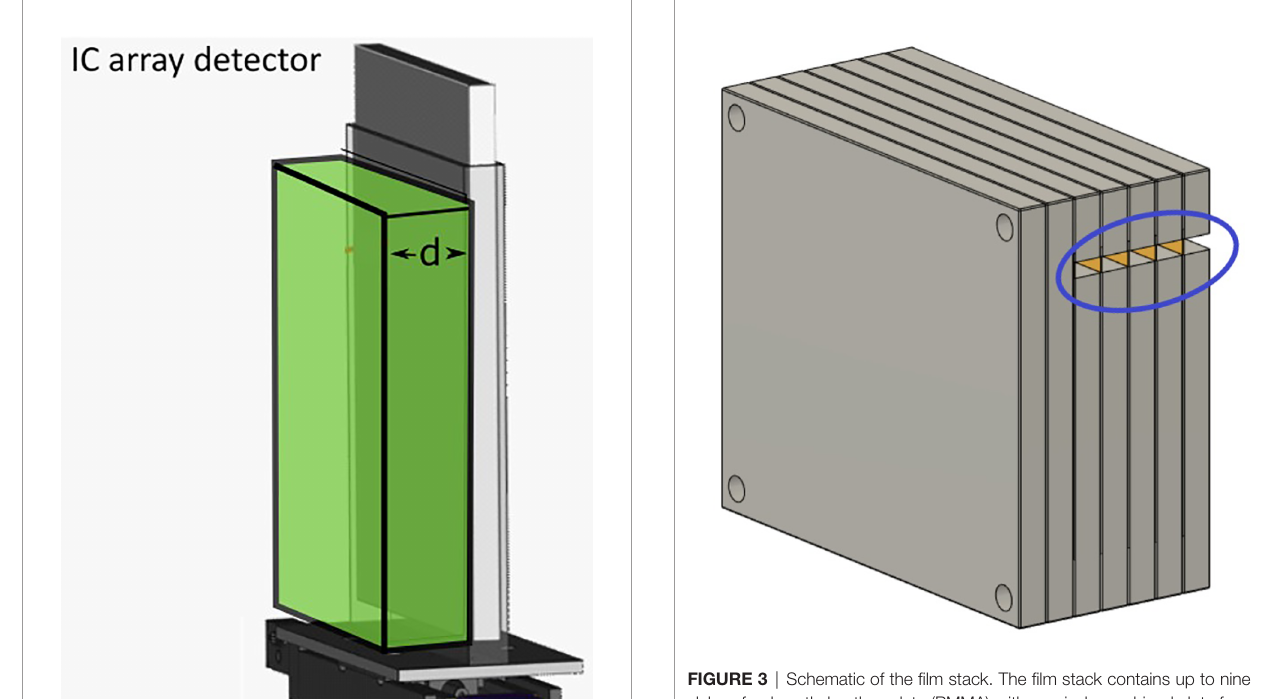
FIGURE 3 | Schematic of the fi lm stack. The fi lm stack contains up to nine slabs of polymethylmethacrylate (PMMA) with precisely machined slots for holding radiochromic fi lms (5 ” × 4 ” ) as well as several slabs of additional PMMA to vary the delivery depth. The phantom measures 15 × 13 × 9 cm 3 when nine slabs are in place. The slabs are aligned and held together by plastic screws at each corner of the phantom. The lateral cutouts (blue circle) are used for easy access of the irradiated fi lms (yellow) without the need to disassemble the fi lm stack phantom.